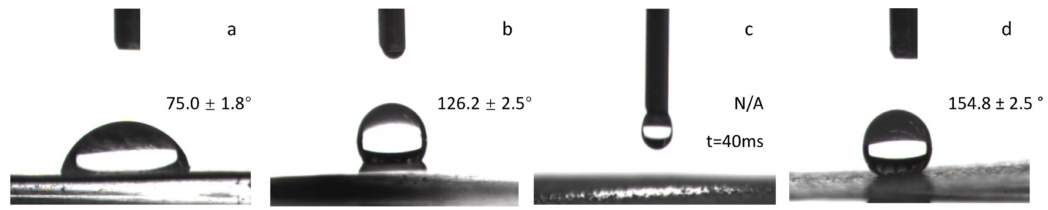
Figure 6. Surface contact angle of zinc substrate ( a ) Unetched zinc substrate, ( b ) Unetched zinc + fluoropolyurethane, ( c ) Cu 2 + / HNO 3 -etched zinc, and ( d ) Cu 2 + / HNO 3 -etched zinc +